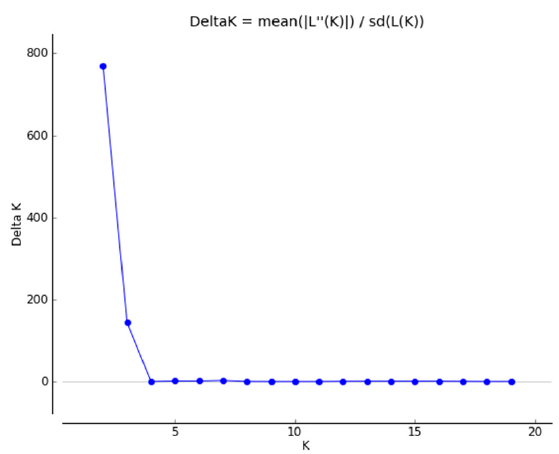
Figure A3. Delta K plot for the Southern Zone.